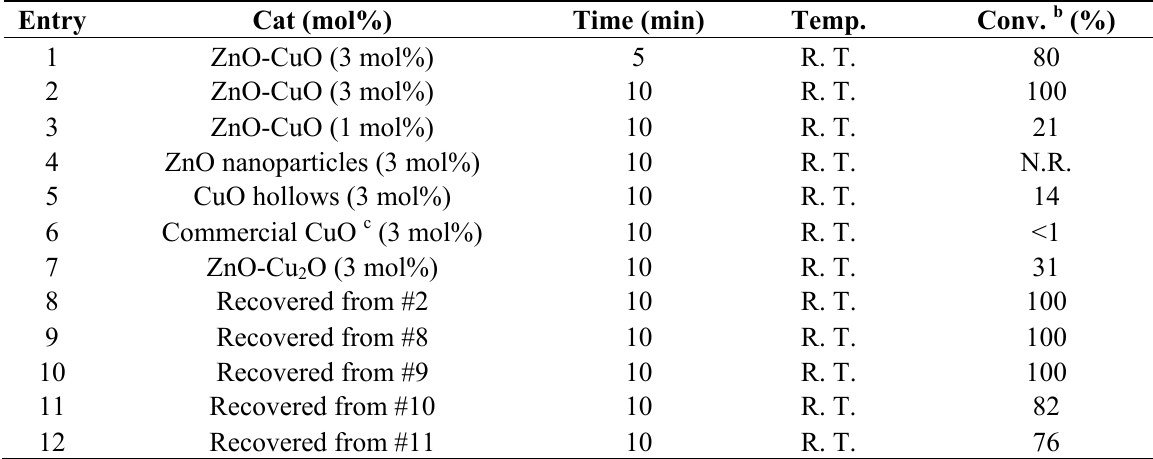
Table 6. [3+2] Azide–alkyne cycloaddition reactions catalyzed by the ZnO–CuO hybrid nanocatalysts under ultrasonic irradiation a